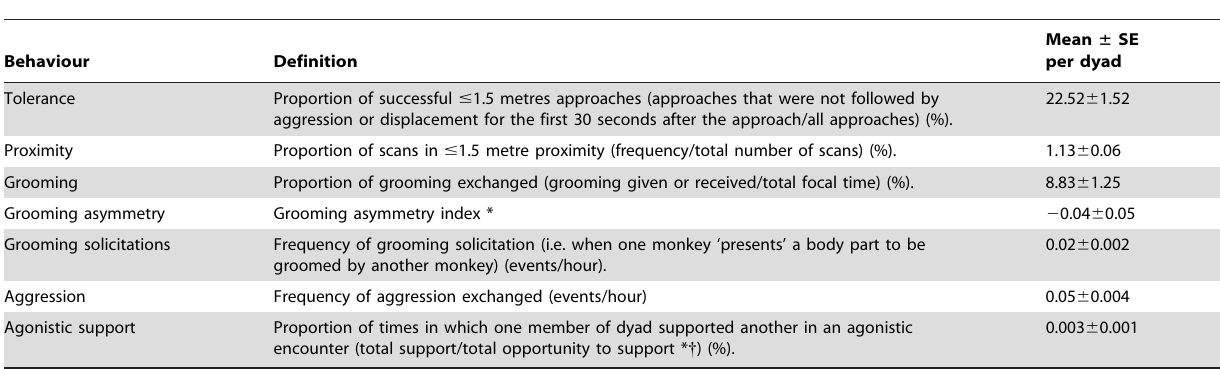
Table 1. Behavioural measures of relationship